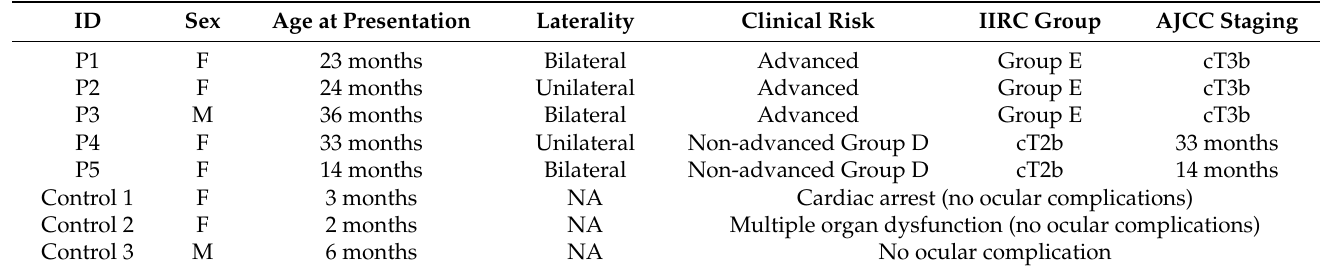
Table 1. Clinical and histopathological details of samples used for